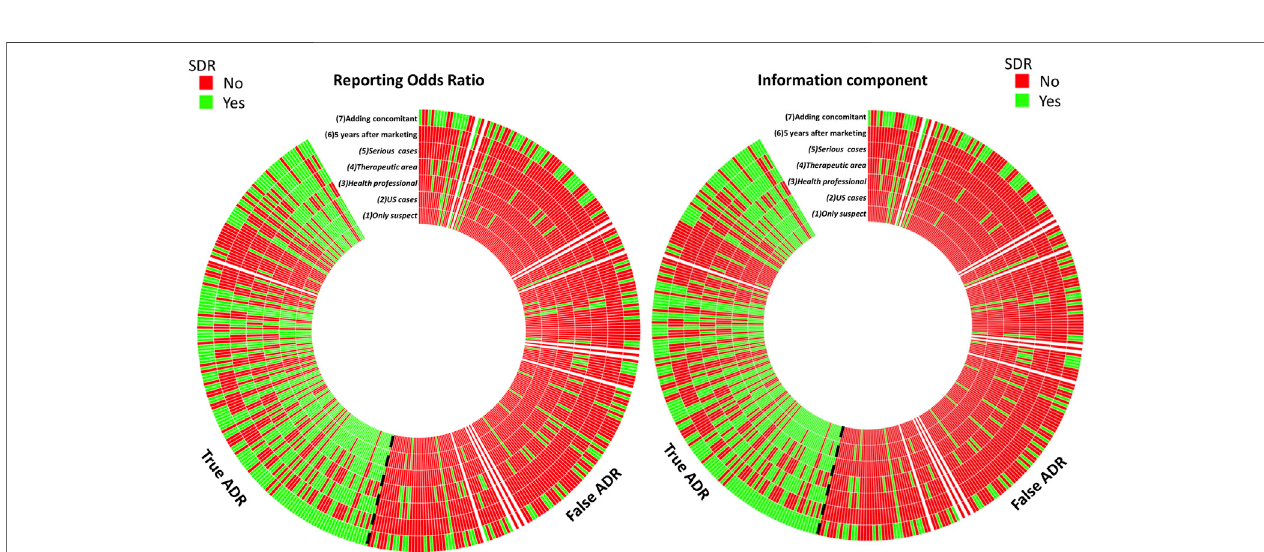
FIGURE2| Numberofpositiveandnegativesignalsofdisproportionatereporting(SDR)withRORandICmethods.Eachlinerepresentsadisproportionalitymodel and each column represents a drug-event pair. A SDR was deemed signi fi cant if ROR LB > 1 and n > 3 for the ROR method, and IC LB > 0 for the IC method.